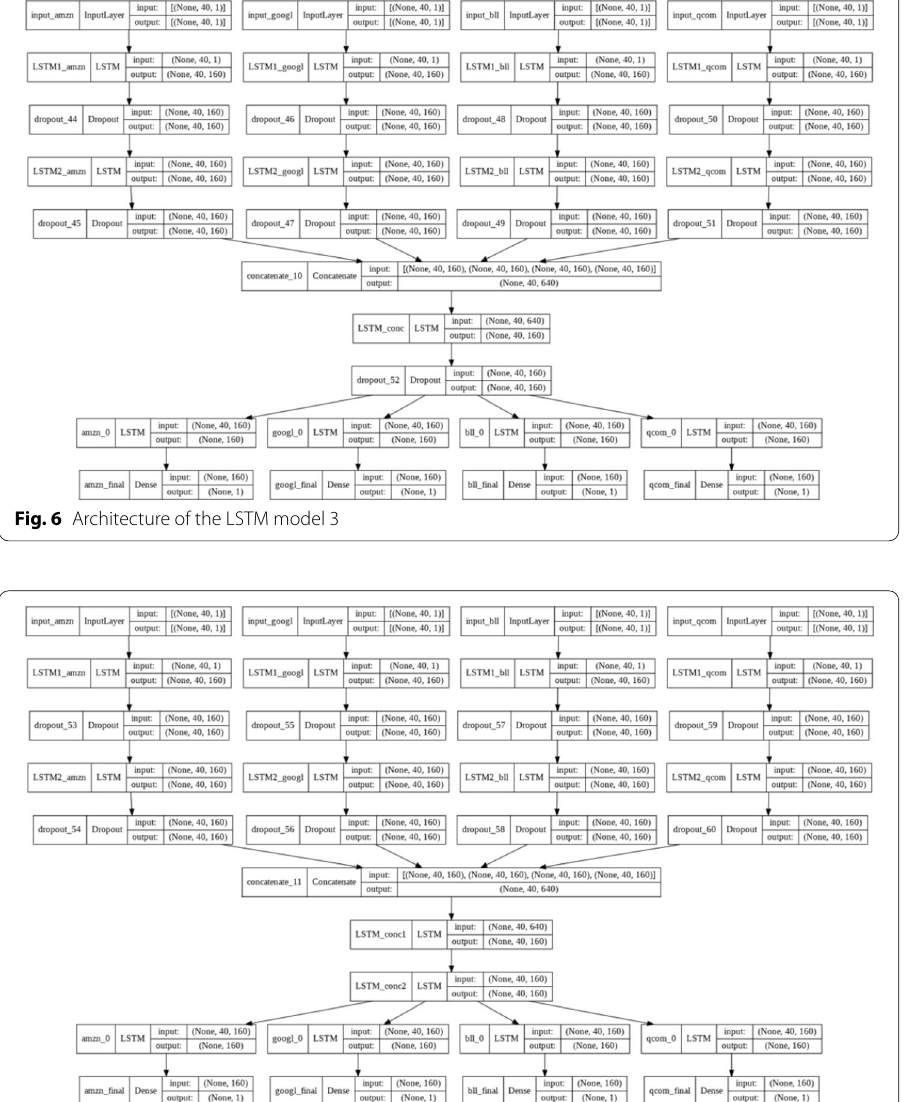
Fig. 7 Architecture of the LSTM model